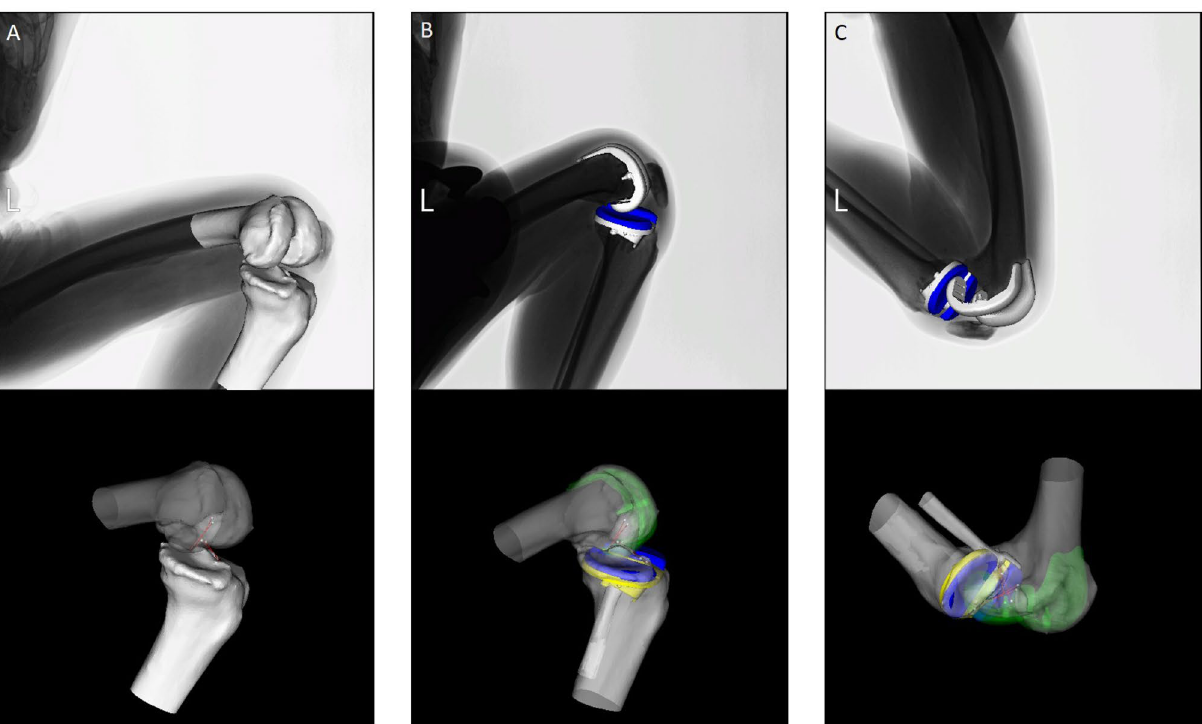
Figure 9. A two-dimensional/three-dimensional (2D/3D) registration and the cruciate ligament force analysis in bicruciate-retaining total knee arthroplasty (images generated by visualization software developed at Osaka University, Osaka, Japan). Red lines at the bottom row indicate the cruciate ligament models: ( A ) Preoperative squatting; ( B ) Postoperative squatting; ( C ) Postoperative cross-legged